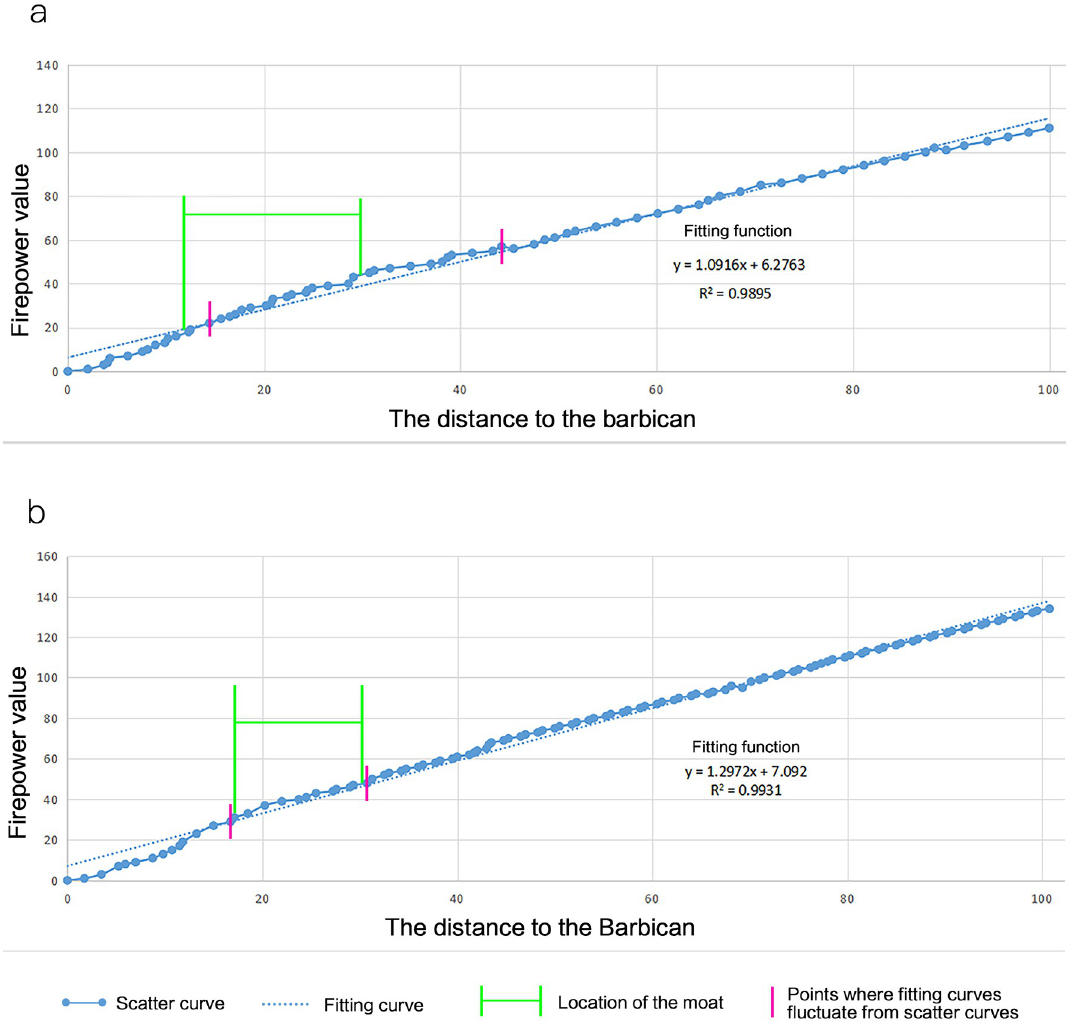
Fig 9. Scattered chart of firepower values in the space under the south wall of the Puzhuang Suo-Fort (a) and scatter diagram of space firepower value under the east wall of Puzhuang Suo-Fort